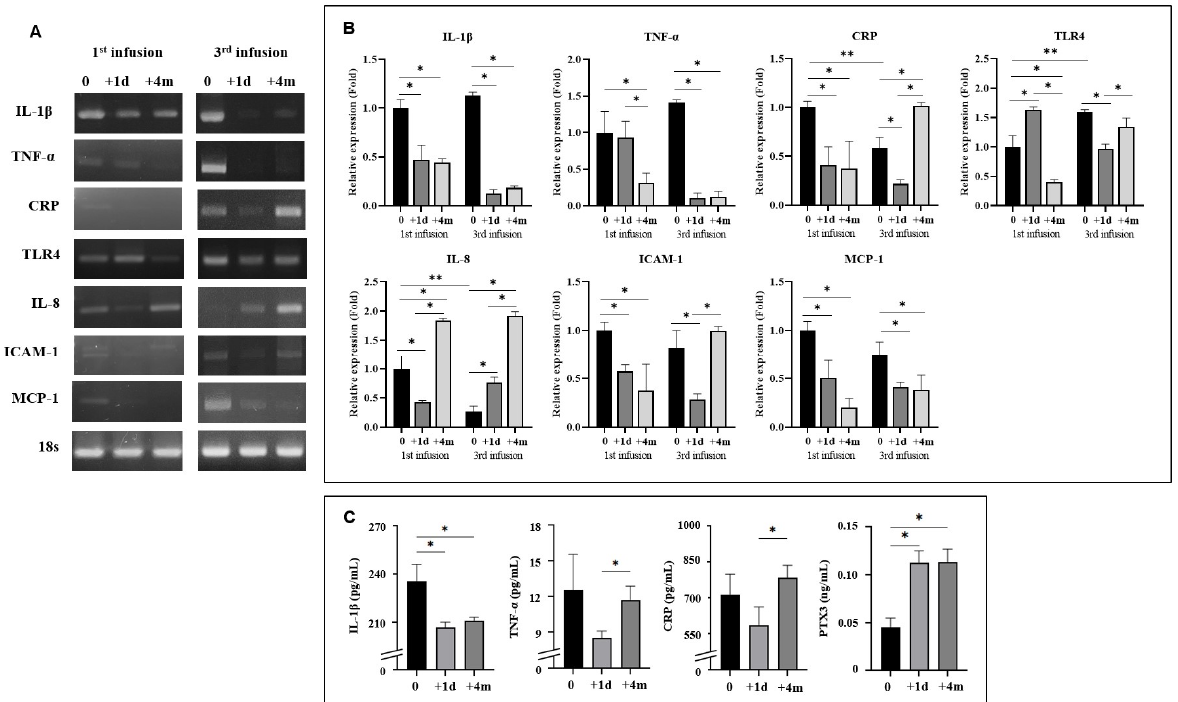
Figure 2. Molecular assays before and after the cord blood cell therapy. ( A ) The mRNA levels of proinflammatory factors, IL-1 β , TNF- α , CRP and TLR4; angiogenic factor, IL-8; and atherosclerotic factors, ICAM-1 and MCP-1 are shown. An 18s gene was used as the reference. ( B ) The relative expressions (expressed as their relative folds compared to the baseline value; 0 of first infusion) of mRNA levels for IL-1 β , TNF- α , CRP, TLR4, IL-8, ICAM-1 and MCP-1, and ( C ) serum ELISA results of proinflammatory factors, IL-1 β , TNF- α , CRP, and innate immune marker, PTX3 are shown in bar graphs. Each peripheral blood sample was drawn on first and third cord blood infusion, before its administration (0), one day after it (+1 d), and four months after it (+4 m). Each experiment was repeated at least three times from the three separate vials, and the data are presented as mean ± standard error. * shows significant difference ( p < 0.05) between periods following each infusion, and ** shows significant difference when comparing the baseline value of first and third infusion analyzed by independent t-test. Abbreviation: IL-1 β , interleukin-1 β ; TNF- α , tumor necrosis factor- α ; CRP, C-reactive protein; IL-8, interleukin-8; TLR4, toll-like receptor 4; ICAM-1, intercellular adhesion molecule-1; and MCP-1, monocyte chemoattractant